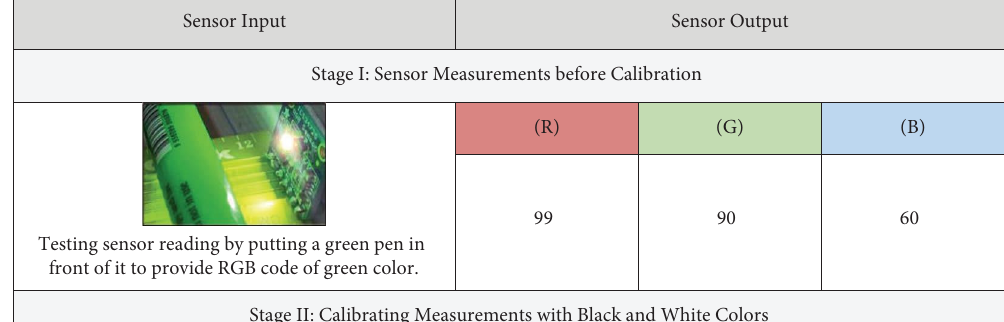
Table 2: Te three main stages of color sensor measurements and their corresponding output. Sensor